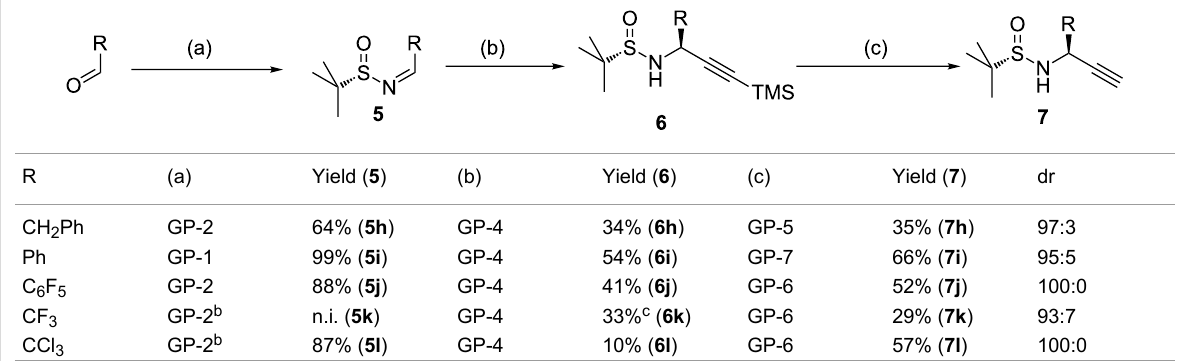
Table 2: Synthesis of propargylamines 7 with electron-withdrawing substituents in the side chain. a